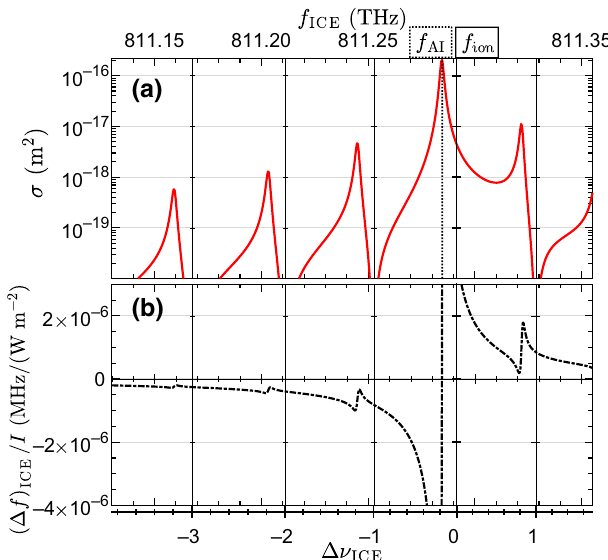
FIG. 2. MQDT theoretical predictions for 6 s 60 s 1 S 0 Rydberg states using R (cid:2) (cid:7) 0.28 and δ e (cid:7) 0.46 obtained experimentally, as a function of f ICE (top scale) and (cid:4)ν ICE (bottom scale). Regularly spaced vertical axes indicate the ion-core frequency f ion (thick line, f ICE (cid:7) 811.291 THz or (cid:4)ν ICE = 0) or the AIZs (thin lines, ∈ N (cid:10) ). (a) The AI cross section (full red line). The vertical (cid:4)ν ICE dotted line marks the cross-section peak at f AI , corresponding to (cid:7) − 0.2. (b) The spectral ICE shift per unit light intensity (cid:4)ν ICE (dashed-dotted black